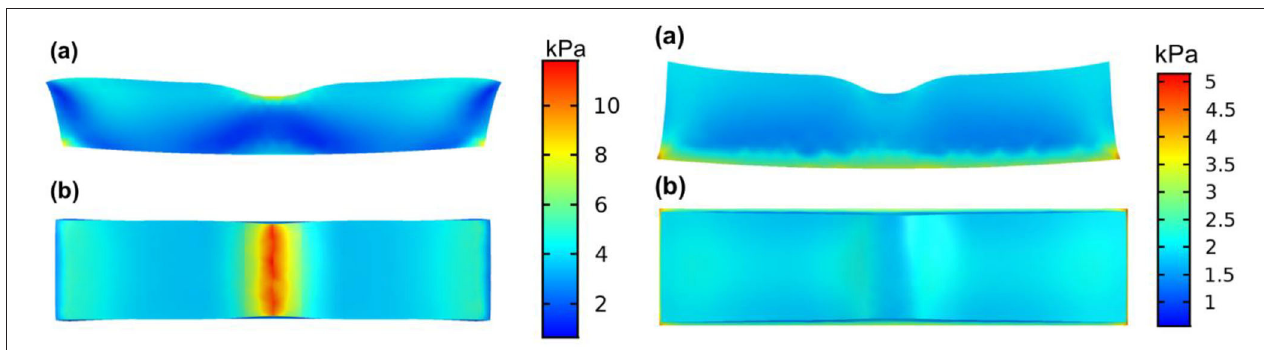
FIGURE 5 | Stress distribution on the retina under forces of different directions applied. The left side shows the horizontal case model, simulating the epiretinal membrane condition. Under such loading condition, the maximum stress position located in the central vitreoretinal interface from the side view (Left a ) and the top view (Left b ), indicating the inner layer of the retina as the weakest point. The right side shows the vertical case model, simulating the vitreomacular traction condition. Under such a loading condition, a stress concentration at the outer retina was seen from the side view (Right a ) and the top view (Right b ), indicating the outer layer of the retina as the weakest